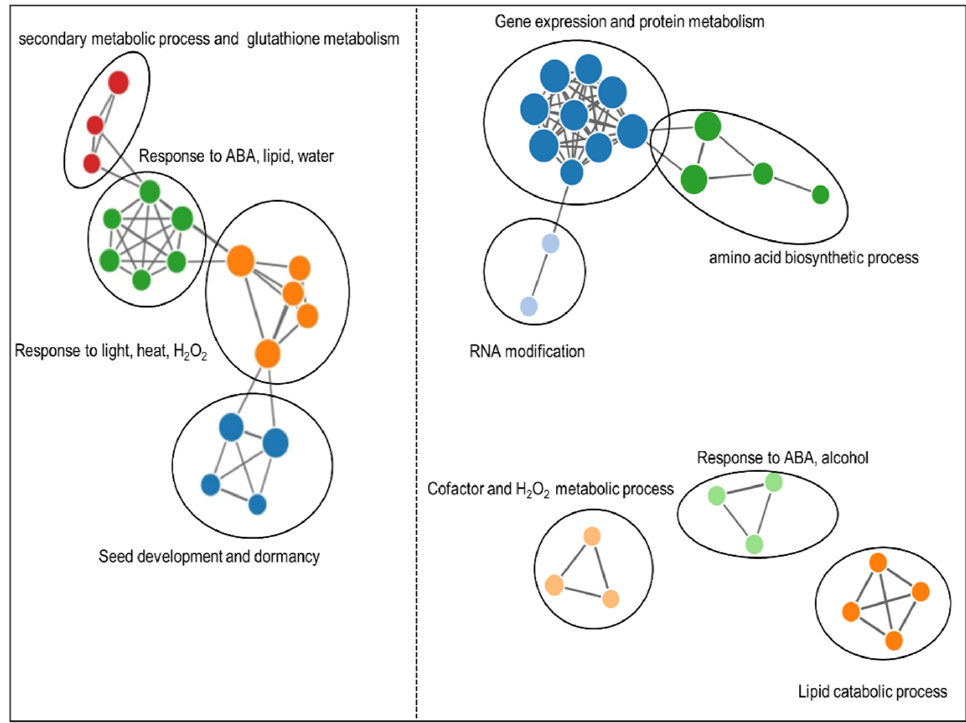
Figure 5. Enrichment map organizing enriched terms of biological process from DEPs in Col+/Col − , into a network with edges connecting overlapping gene sets. The left part represents enrichment map from down-regulated proteins in Col+/Col − , while the right part represents enrichment map from up-regulated proteins in Col+/Col − . Each node corresponds to significant biological process, and the size of the node indicates gene numbers in each set, while the edge connects the overlapping gene set. Distinct colors are given to different clusters calculated by walktrap community finding algorithm [46,47].